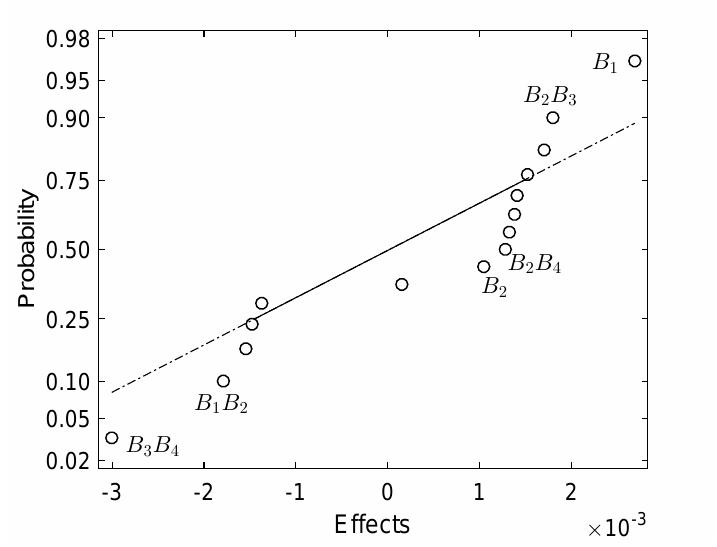
Figure 10. Normal probability plots for stage II showing effects on efficiency (total to